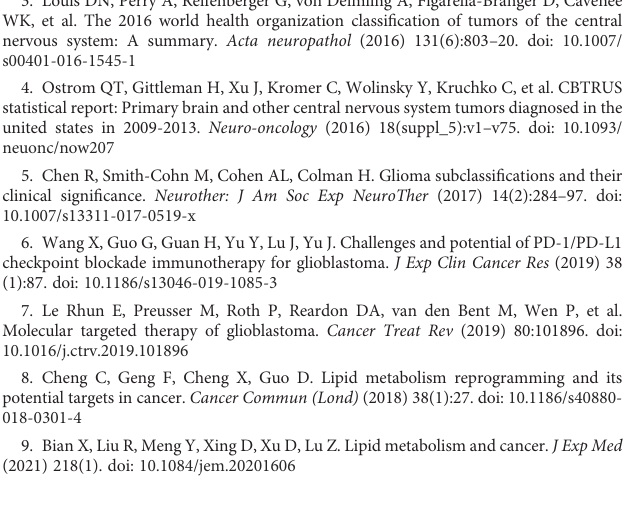
SUPPLEMENTARY TABLE 2 Lipid metabolism-related genes and corresponding lipid metabolism pathway.